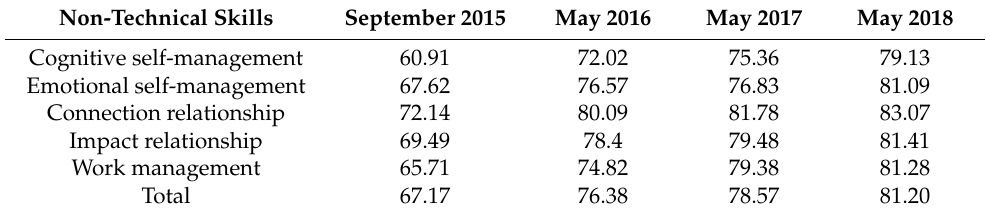
Table 3. Mentee acquired